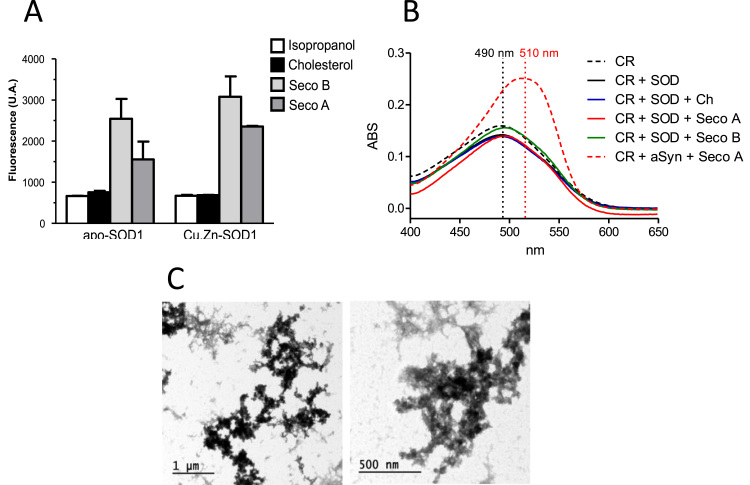
Morphology of SOD1 aggregates formed in the presence of secosterol aldehydes. (A) Effect of secosterol aldehydes on the exposition of hydrophobic residues of SOD1 analyzed by thioflavin T fluorescence assay. (B) Absorption spectrum of congo red obtained for incubation containing SOD1 and cholesterol or secosterol aldehydes (Seco A or Seco B). As positive control for fibrillar aggregates we used α-synuclein incubated with Seco A (dashed red line), which showed the typical spectral red shift. (C) Transmission electronic microscopy (TEM) images of the apo-SOD1 WT incubated with Seco B showing granules with amorphous morphology.